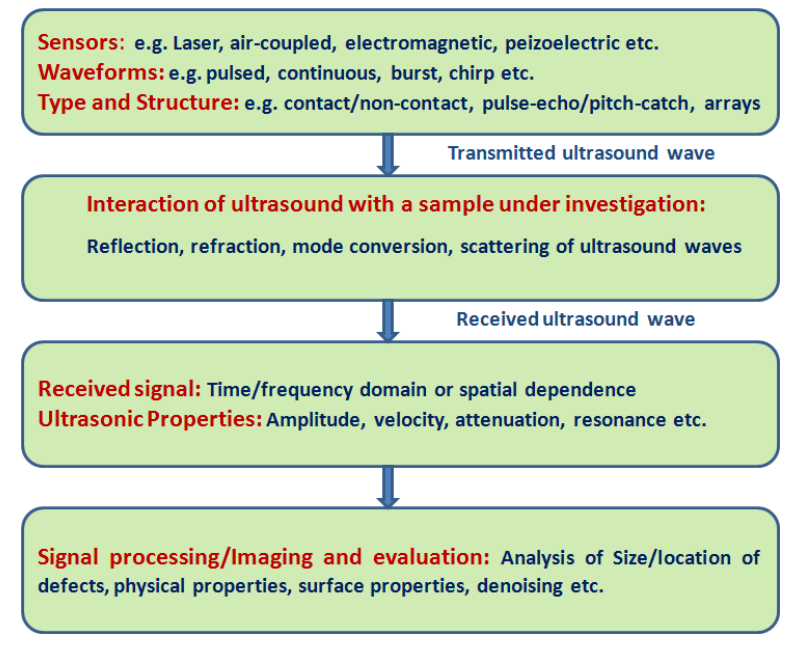
Figure 1. The basic structure of ultrasonic measurement system.